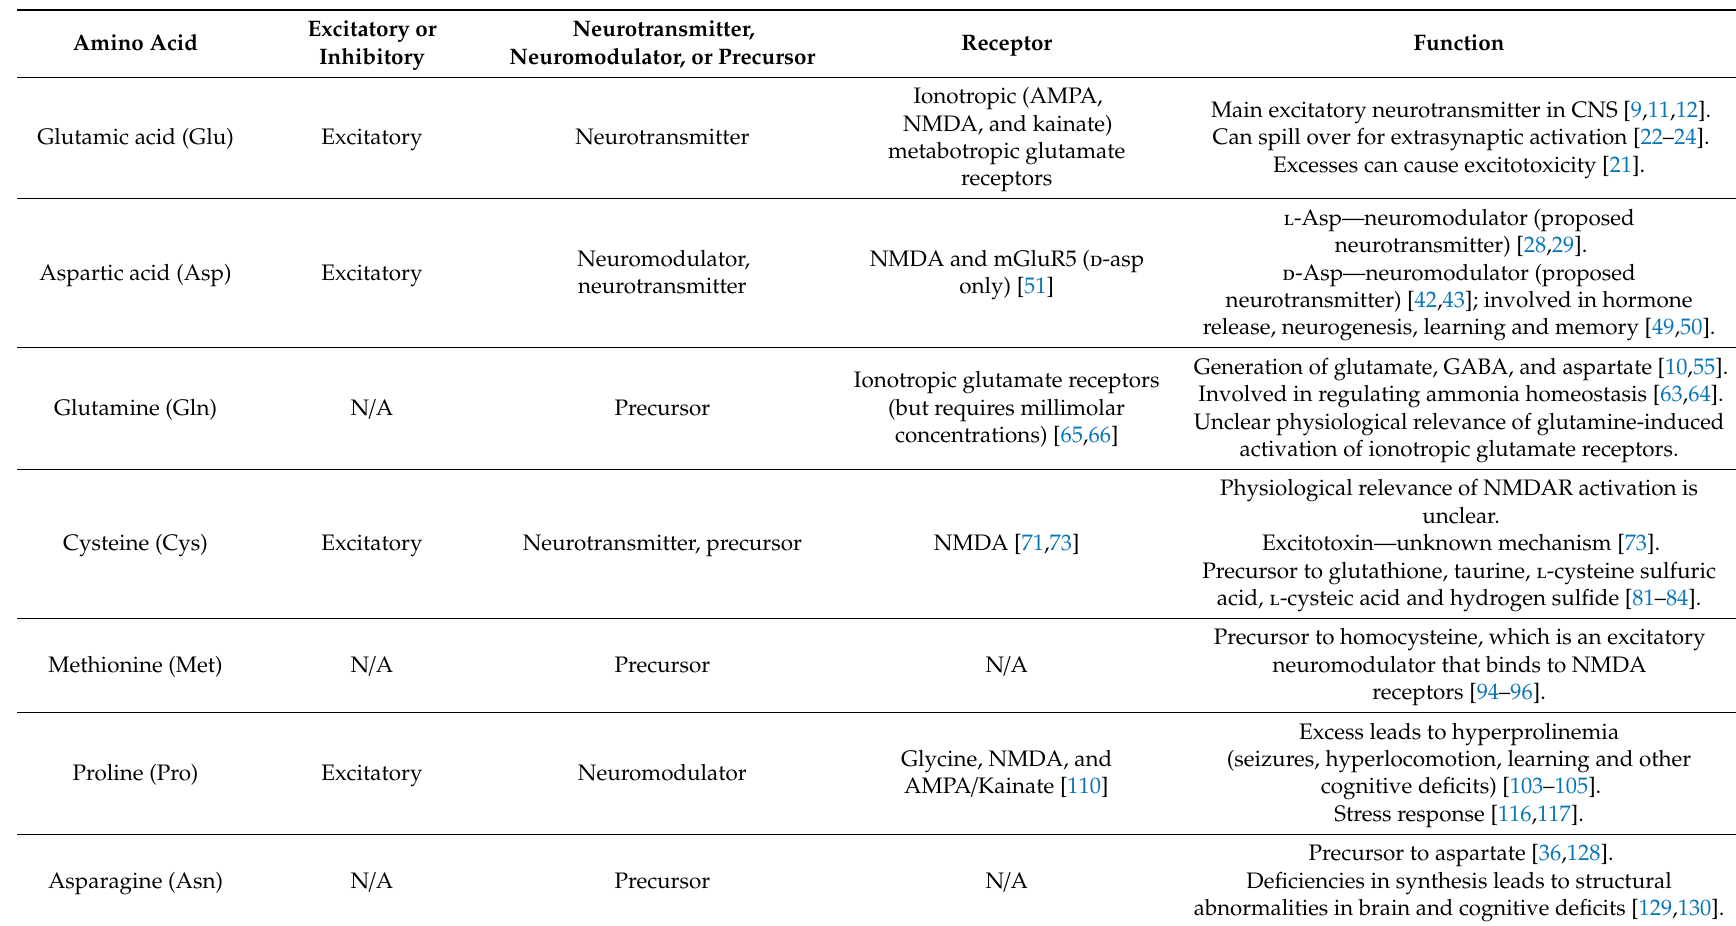
Table 1. Amino acids and their roles in neurotransmission. See main text for complete